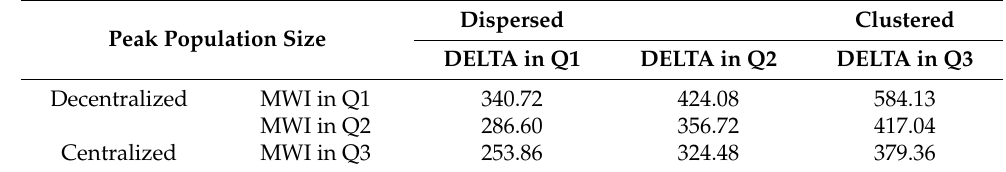
Table 8. Peak city population size (in 10,000) relative to GDP per worker (2013).